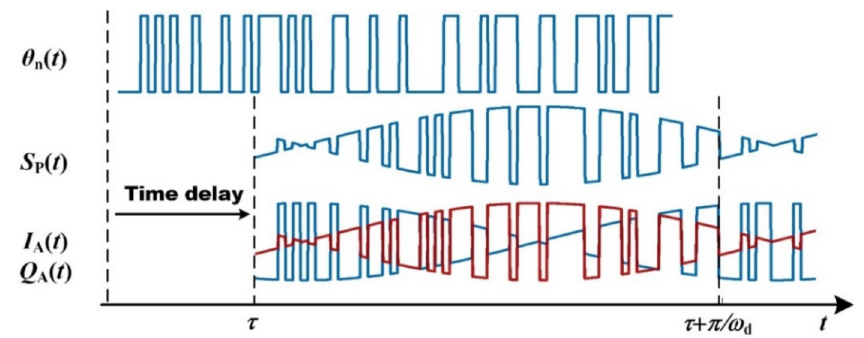
Figure 1. Schematic illustration of waveforms for θ n ( t ), S P ( t ), I A ( t ) (red line), and Q A ( t ) (blue